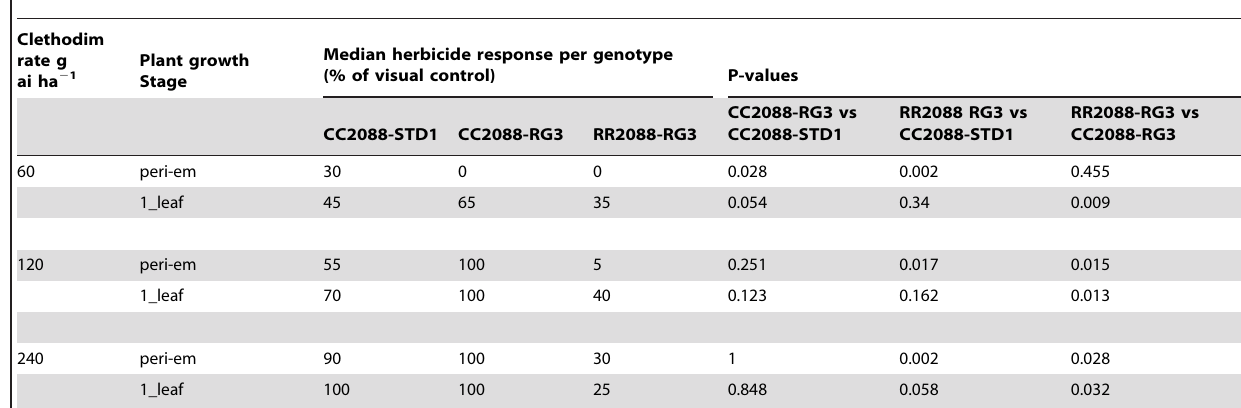
Table 4. Efficacy of clethodim on different 2088 ACCase genotypes and plant growth stages. Genotypes compared using Wilcoxon rank sum